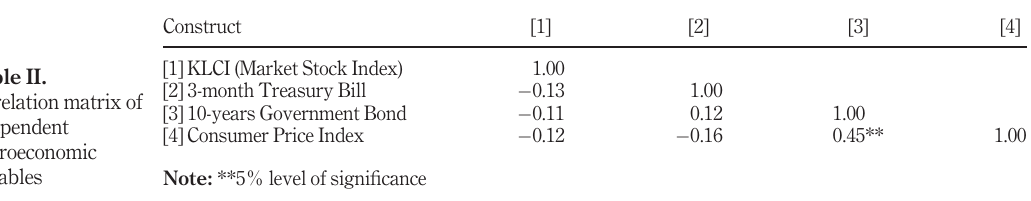
Table II. Correlation matrix